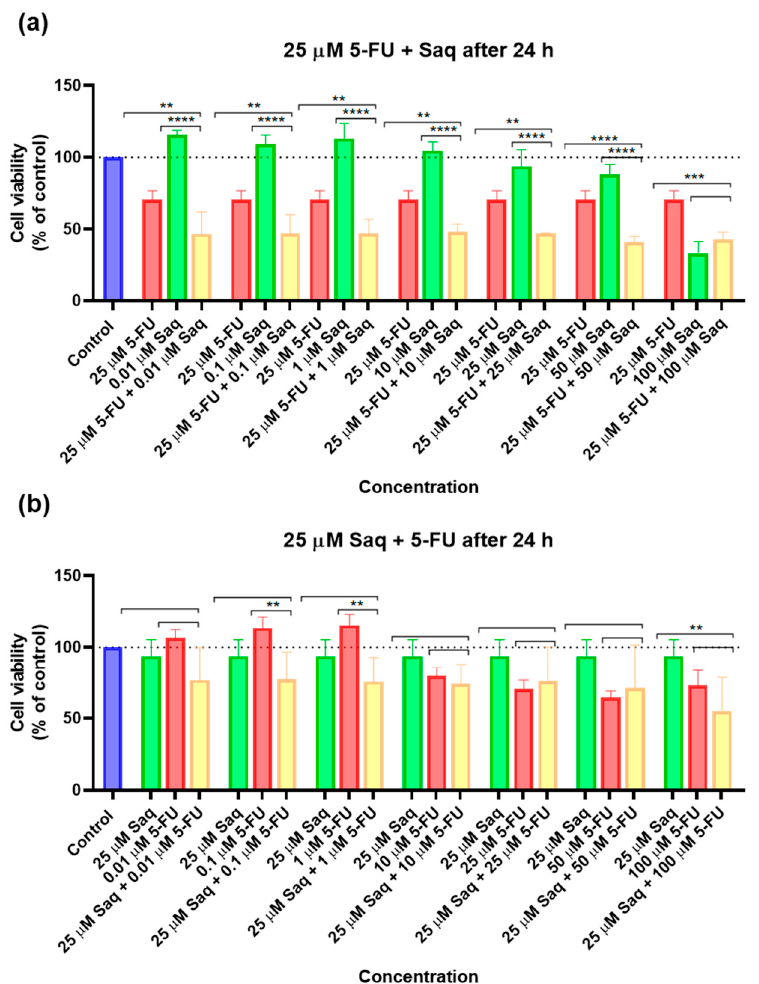
Figure 19. Cytotoxic results of A549 after exposure to drug combinations with the second drug only being added 24 h after the first. ( a ) Combination of 25 µ M of 5-FU with increasing concentrations of saquinavir (0.01–100 µ M); ( b ) combination of 25 µ M of saquinavir with increasing concentrations of 5-FU (0.01–100 µ M). Control cells were treated with 0.01% DMSO (vehicle). Cell viability was obtained using the MTT assay after 48 h, and the results are given as the mean ± SEM ( n = 3). ** statistically significant vs. drug alone at p < 0.01; *** statistically significant vs. drug alone at p < 0.001; **** statistically significant vs. drug alone at p < 0.0001.